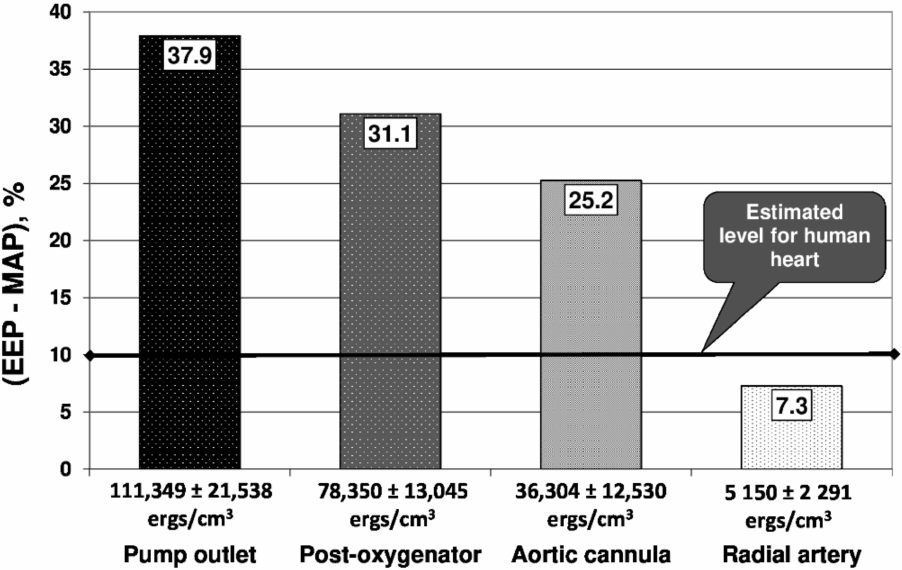
Figure 2. Hydrodynamic evaluation of “Blood pump—CPB circuit—Patient” system by means of EEP and SHE. Each diagram represents a mean percentage difference between EEP and MAP with a corresponding level of SHE (ergs/cm 3 ) as a